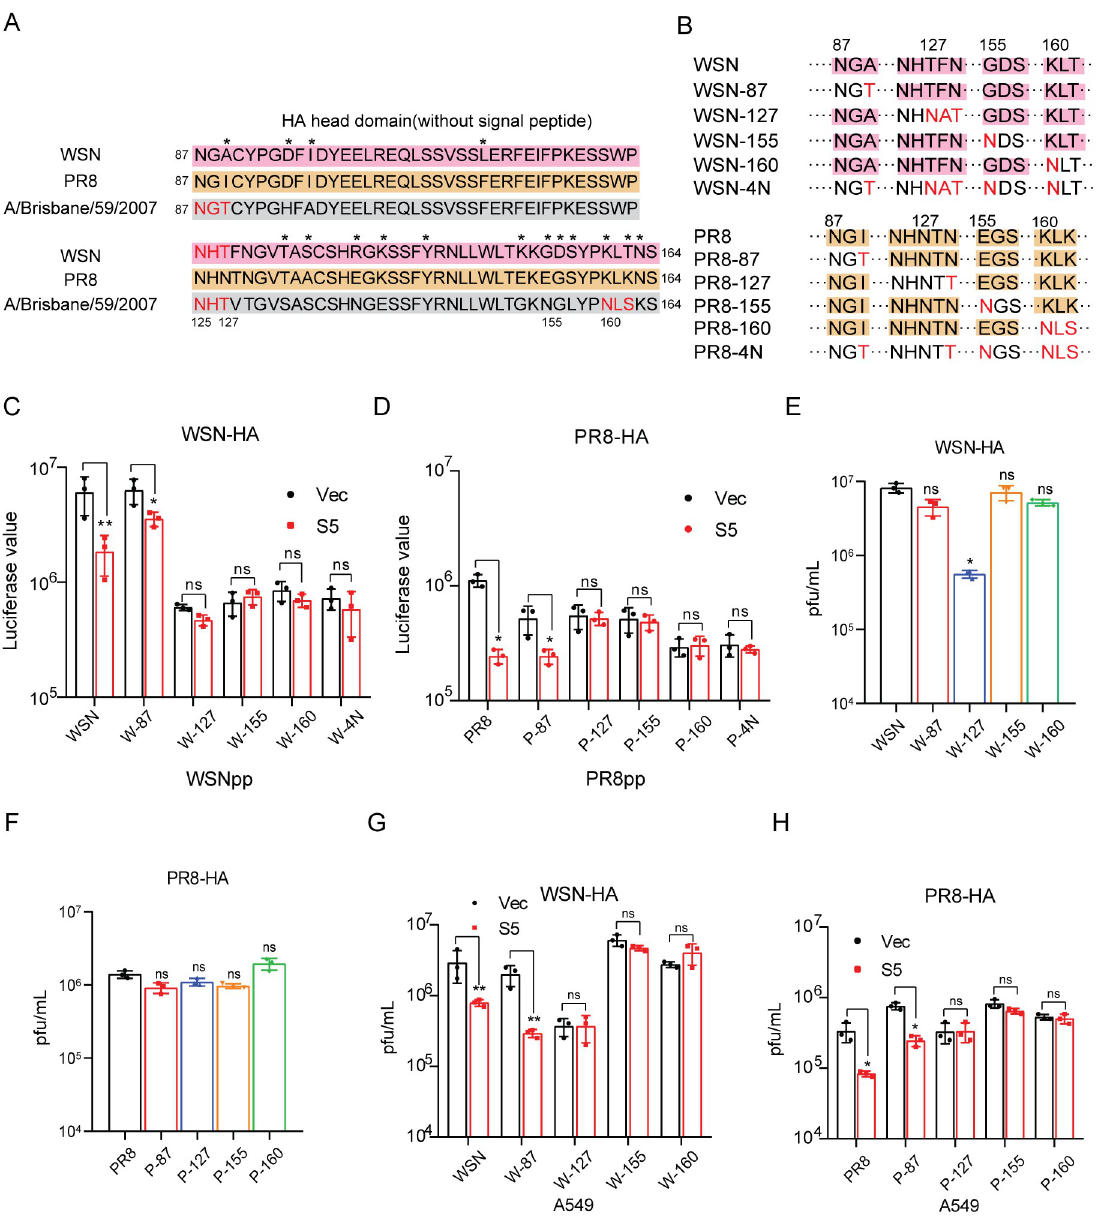
Fig 5. HA glycosylation sites modulate the sensitivity to SERINC5. A: The glycosylation sites in the HA head domain of HA1-WSN, HA1-PR8 and HA1-A/Brisbane/59/2007. Different amino acids are marked with asterisks. N-glycosylation site were highlighted with red. B: Schematic representation of IAV WSN and PR8 HA mutations. C-D: HA mutants were used to pseudotype lentivirus particles that were produced by transfecting HEK293T cells with plasmid psPAX2, LentiGFP/Luc and pCAGGS-NA. Viruses of equal viral p24 Gag amounts were used to infect A549 cells with SERINC5 overexpression (C) or SERINC5 knockout (D). Luciferase activity was measured to report viral infection. E-H: IAV was produced by transfecting HEK293T cells with the mutated WSN-HA (E, G) or PR8-HA (F, H) and the rest 7 viral DNA segments. Titers of viruses were determined by viral plaque assays (E, F). After infecting A549 cells that stably overexpress SERINC5 at MOI = 0.01 for 24 h, titers of IAV in the supernatant were determined by viral plaque assay (G, H). Results shown are the averages of three independent experiments. Statistical significance was calculated with unpaired t -test. ns: not significant; � : P < 0.05; �� : P <